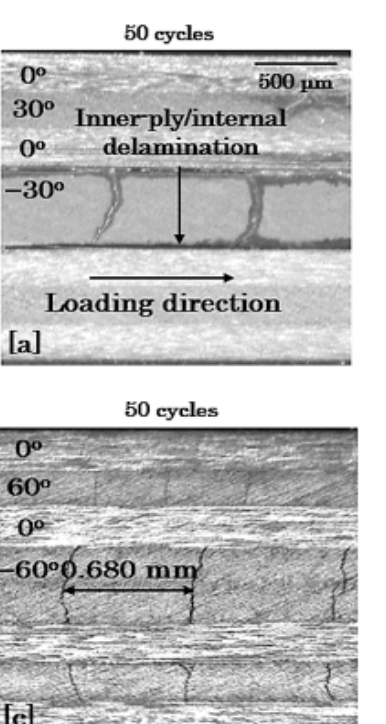
Figure 20. Damage in [0°/30°/ − 30°] 2s (top) and [0°/60°/ − 60°] 2s (bottom) laminates after ( a , c ) 50 and ( b , d ) 200 cycles for σ max = 0.8 × σ ult and R = 0.1.